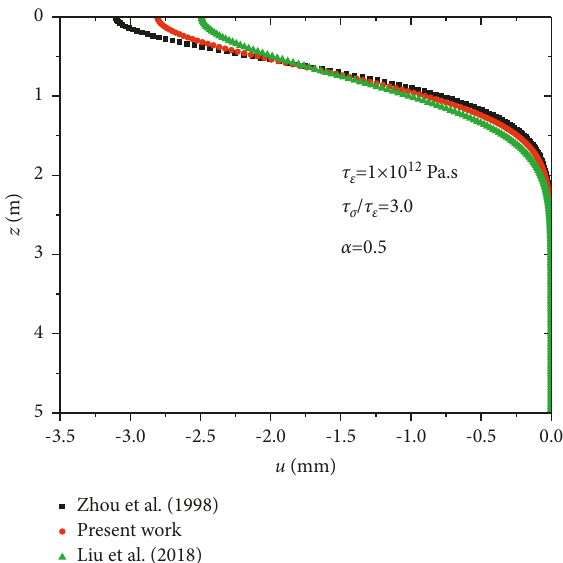
Figure 3: Comparison of displacement among solutions of Zhou et al. [25], Liu et al. [14], and present